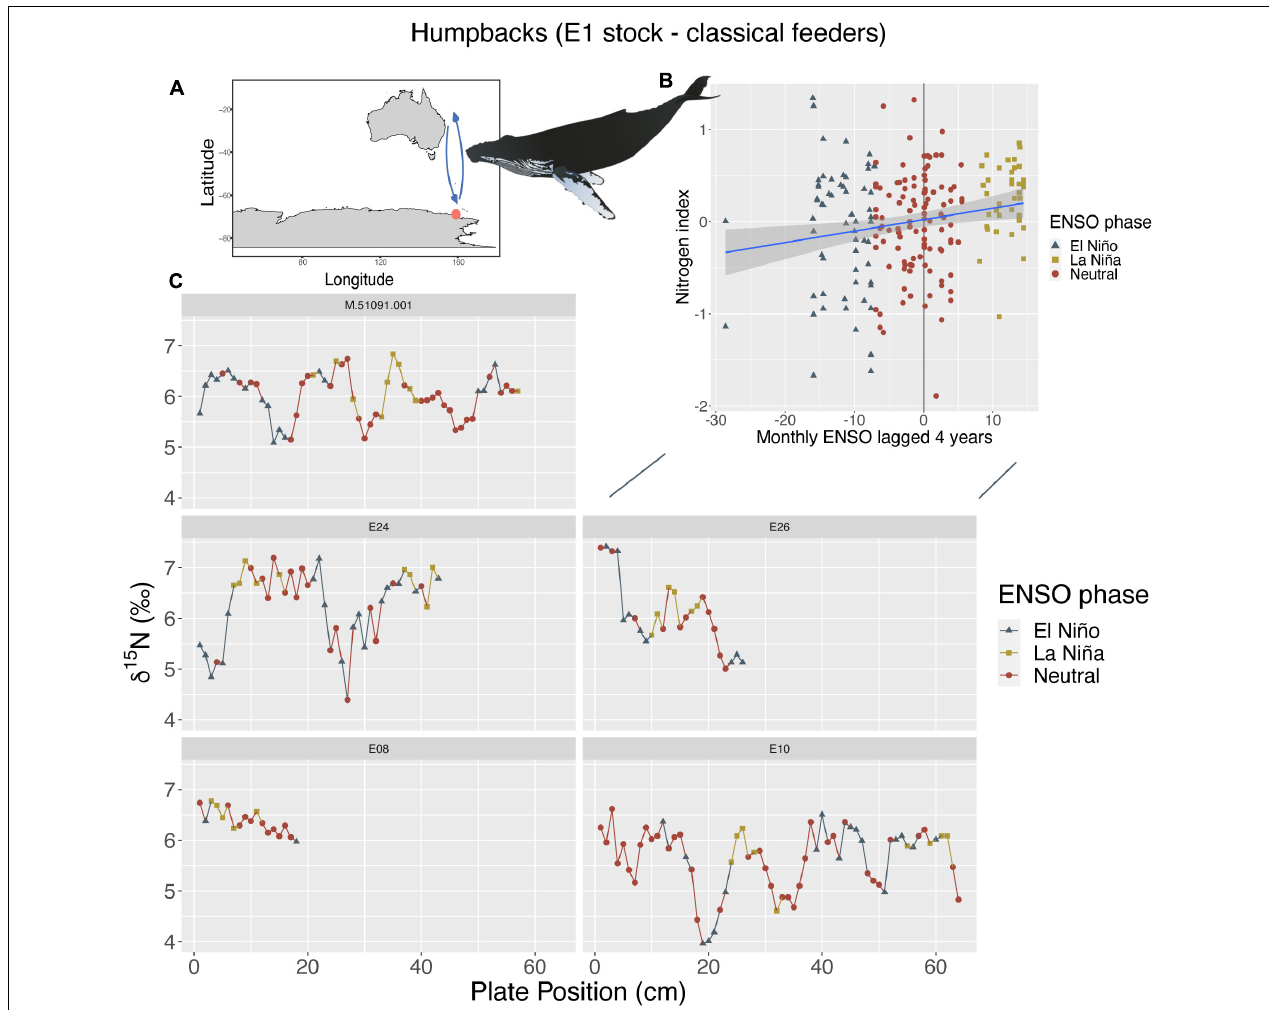
FIGURE 1 | (A) Humpbacks from the E1 breeding stock ( n = 5, sample points = 208) that primarily feed within the Southwest Pacific Ocean (known as classical feeders, orange circle = feeding location, arrows = migration route), show a positive linear relationship between their nitrogen index and ENSO (B) with a 4-year lag period ( p < 0.01; R 2 m = 0.04). (C) Shows where these changes in ENSO phases occur along baleen and resulting stable isotope patterns of δ 15 N for each individual. Whale image attribution: Tracey Saxby, Integration and Application Network